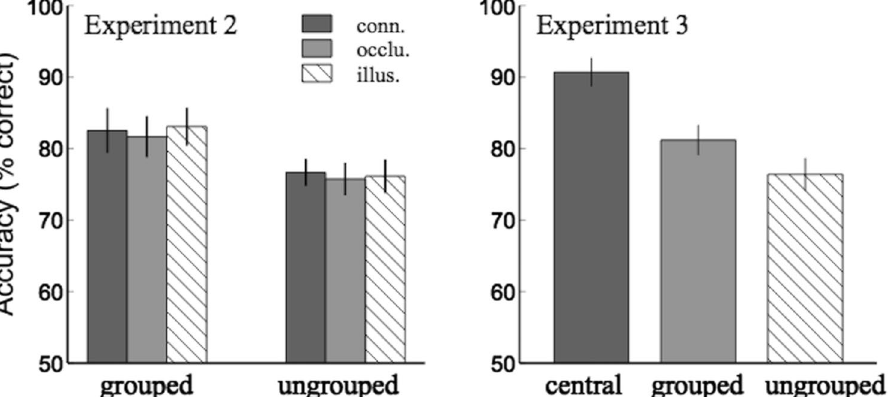
Figure 4. Results of Experiment 2 & 3. Left panel: comparison between the average change detection accuracies for the items inside (grouped) and outside (ungrouped) the Kanizsa triangle in Experiment 2. Right panel: comparison among the accuracies for the central, grouped, and ungrouped items in Experiment 3. Error bars indicated standard errors of the